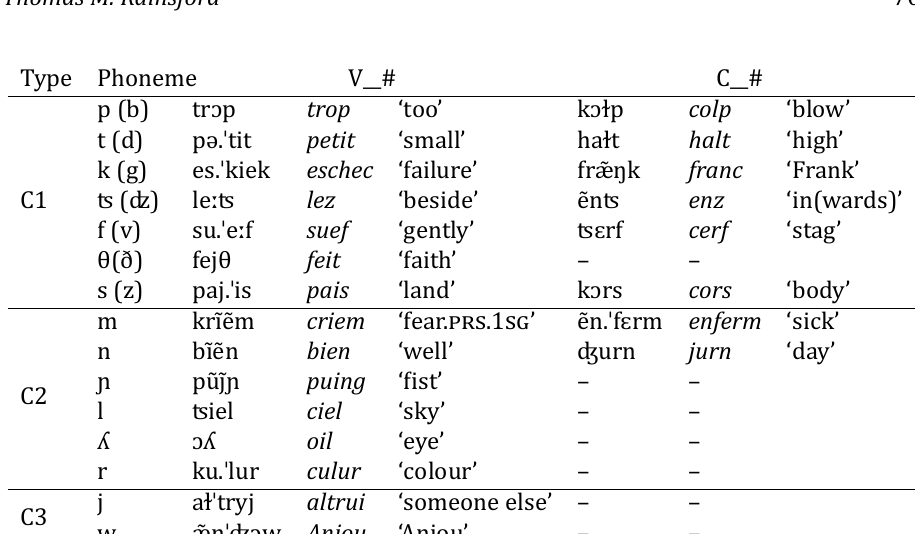
Table 3: Type C: Clusters attested both in ˈV__ə# and ˈV__# contexts.